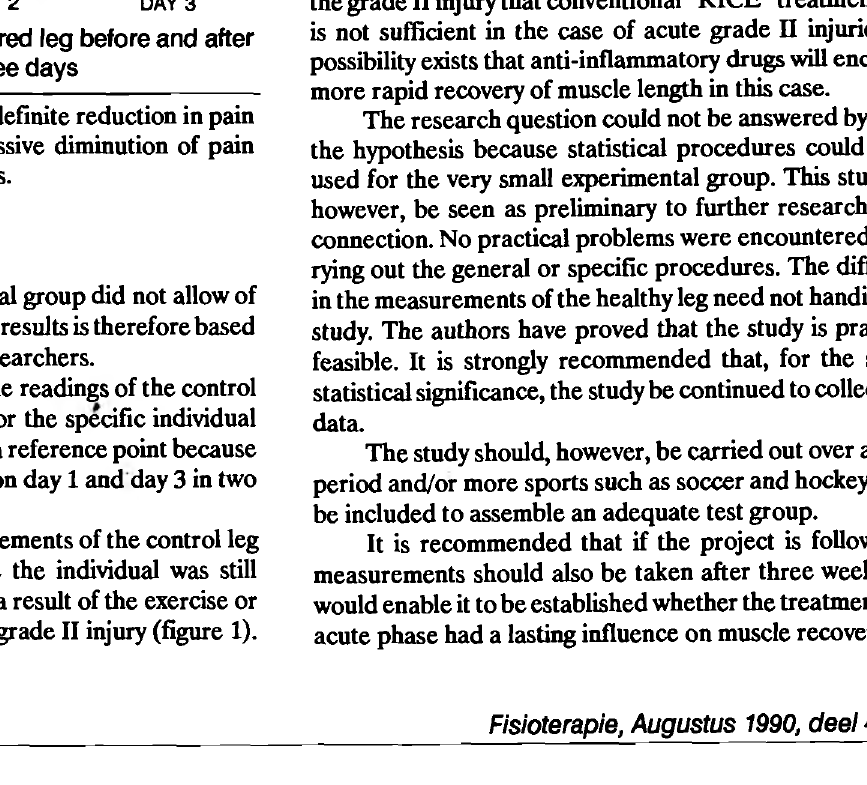
FIG 2. Hamstring length of the injured leg before and after treatment over three